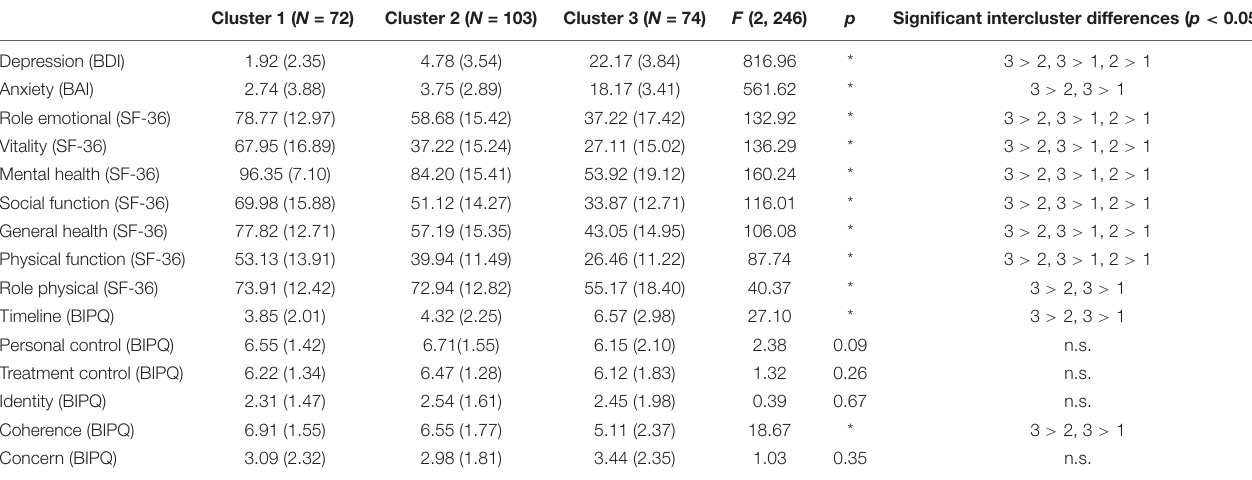
TABLE 2 | Means, SD, and ANOVAs of the cluster